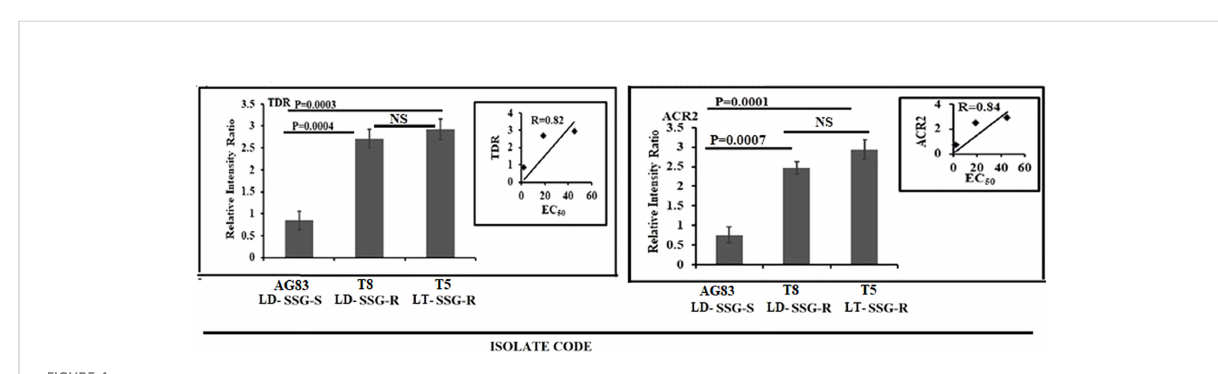
FIGURE 4 Graphical representation of the densitometric data of the genes responsible for the reduction of pentavalent to trivalent antimony. The expressions of ACR2 and TDR were expressed as the ratio of ACR2 and TDR mRNA levels to GAPDH mRNA level, respectively. Data were expressed as the mean ± SD of three independent experiments. Each scatter plot in the inset represents the correlation between the EC 50 of the isolates against sodium stibogluconate and the respective gene expression. NS, Non-signi fi